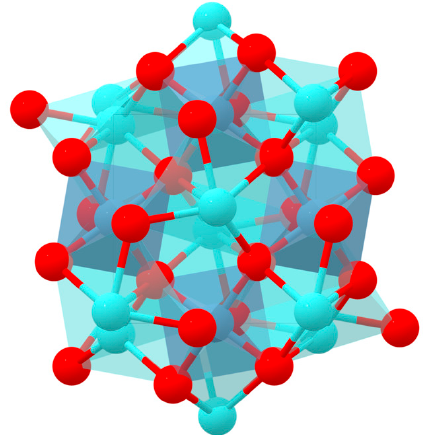
Figure 1. Theoretical structure of YAlO 3 [15]. Data retrieved from the Materials Project for YAlO 3 (mp-3792) (database version v2022.10.28).